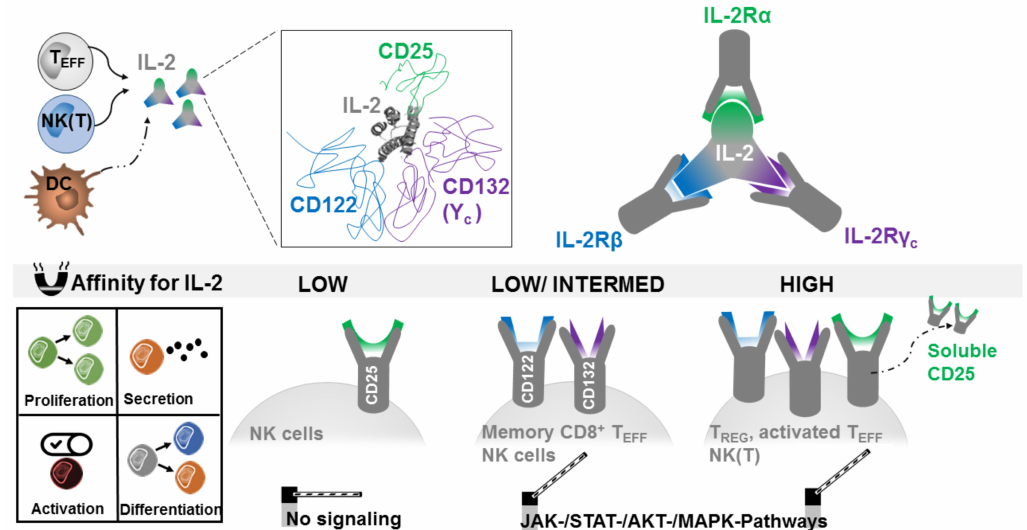
Figure 1. Interleukin-2 (IL-2) production, epitopes, and receptors. Interleukin-2 produced by T e ff ector cells (T EFF ), natural killer (T) cells (NK(T)), and dendritic cells (DC) binds to IL-2 receptors (IL-2Rs) CD25, CD122, and CD132. CD25 can be cleaved from the surface as a soluble form. Coexpression of CD122 and CD132 found on CD8 memory T cells has a low to intermediate IL-2 a ffi nity, whereas the expression of all three receptors on activated T cells as well as regulatory T cells has high IL-2 a ffi nity. IL-2-signaling pathways utilize di ff erent transcription factors and lead to proliferation, secretion of cytokines, activation, and di ff erentiation of T